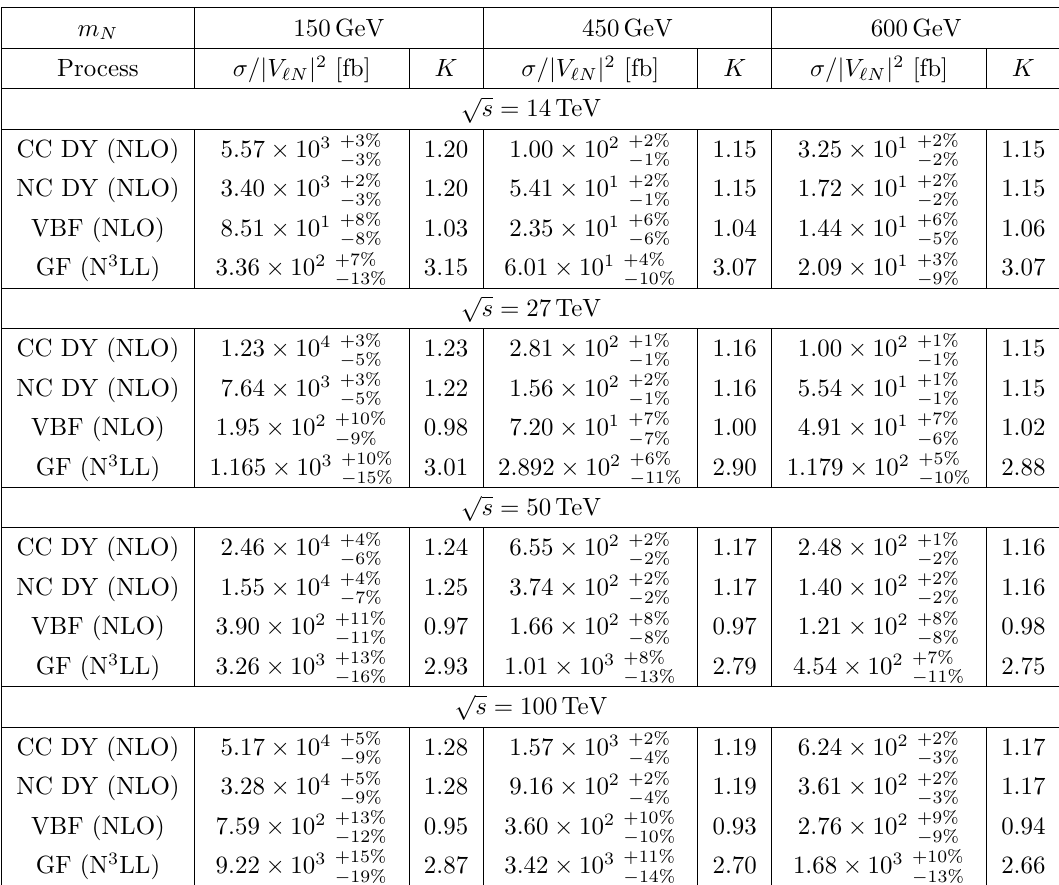
Table 1. Leading heavy N production cross sections [fb] at various accuracies, divided by mixing 2 , with residual scale dependence (%) and QCD K -factor, for representative m V ‘N j j